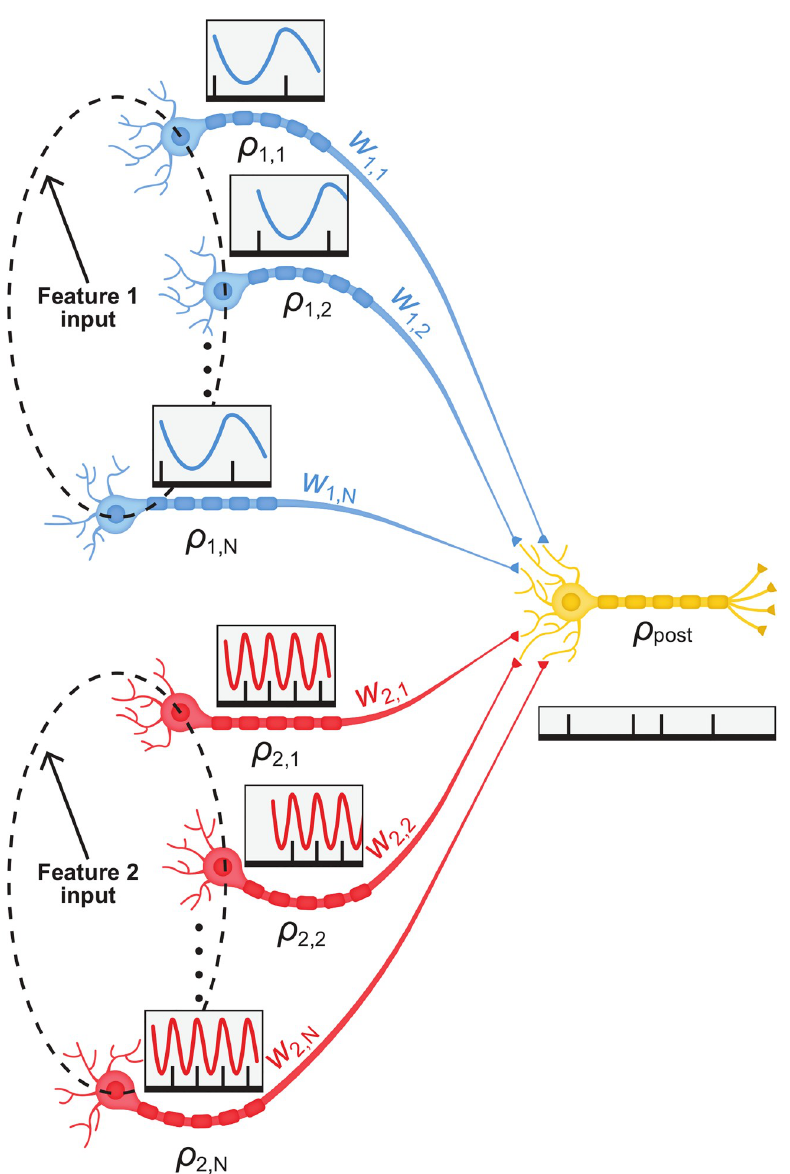
Fig 1. Network architecture. A schematic description of the network architecture showing two pre-synaptic populations, each oscillating at a different frequency. The output of these pre-synaptic neurons, serves as a feed- forward input to a single post-synaptic